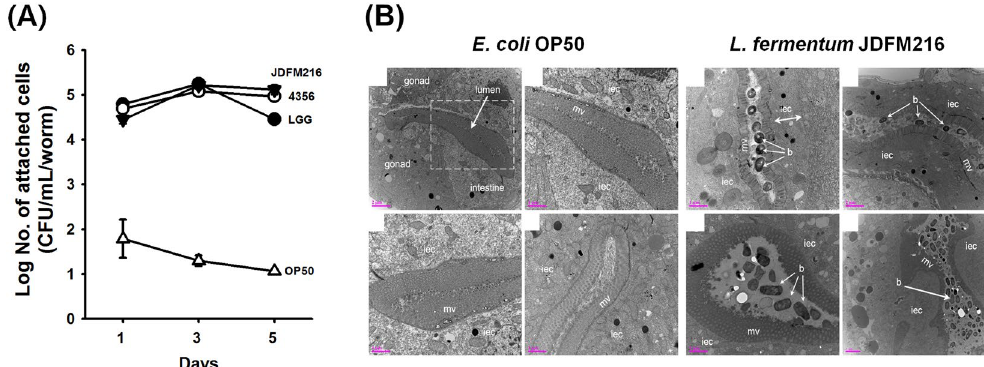
Figure 2. ( A ) Plate counting and ( B ) transmission electron microscopy (TEM) images indicated that the Lactobacillus fermentum strain JDFM216 was highly attached on the C. elegans intestine compared with E. coli OP50. Scale bar is 2 μ m.